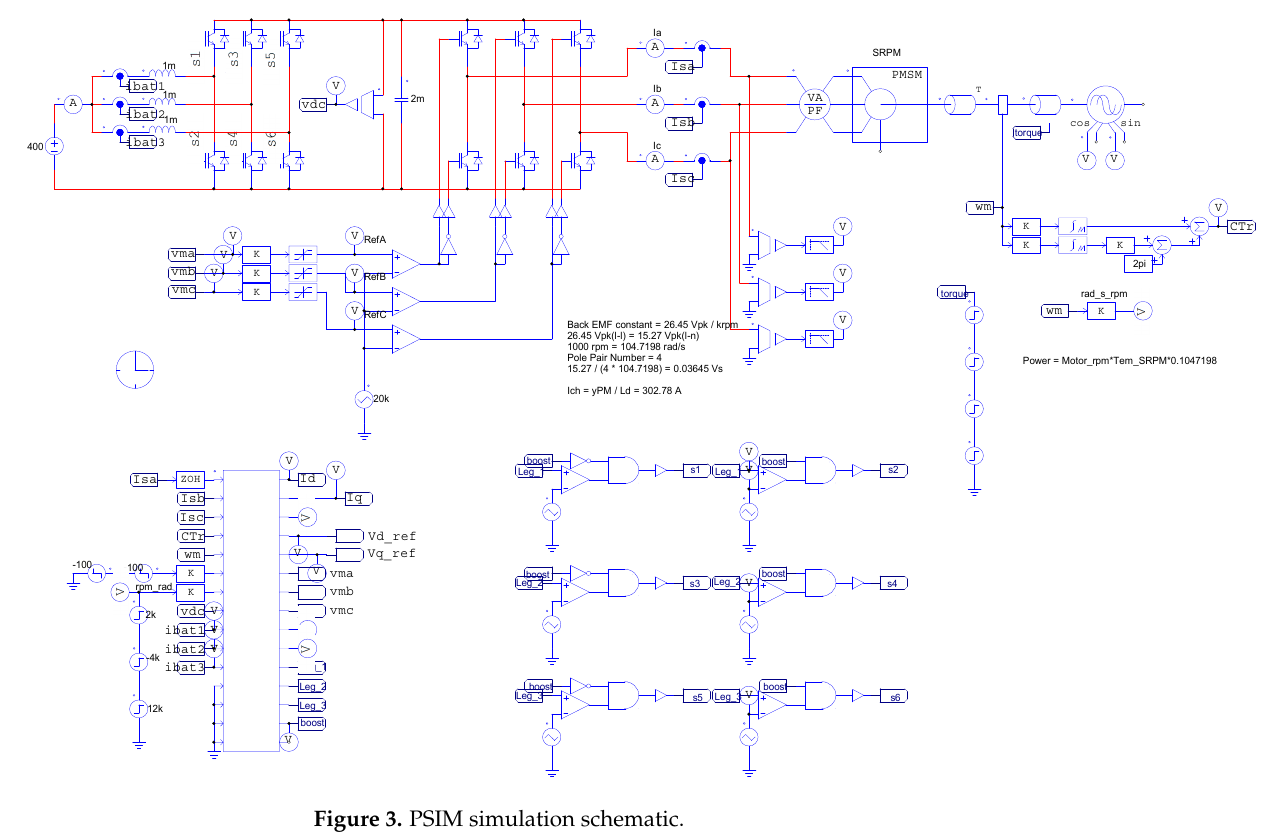
Figure 3. PSIM simulation schematic. Figure 4 presents the simulation results obtained for the SRPM machine at nominal speed, coupled with a load of 50 Nm, showing the applied voltages and currents in the stator windings in both the abc and dq coordinate systems. More speci fi cally, in Figure 4a, the electric machine is rotating in the positive direction, which can be con fi rmed by the sequence of phases being abc . In the case of Figure 4b, the sequence of phases becomes acb , representing a negative direction of rotation, resulting in inverted values for both i q and v q , as expected, validating Park’s transform.